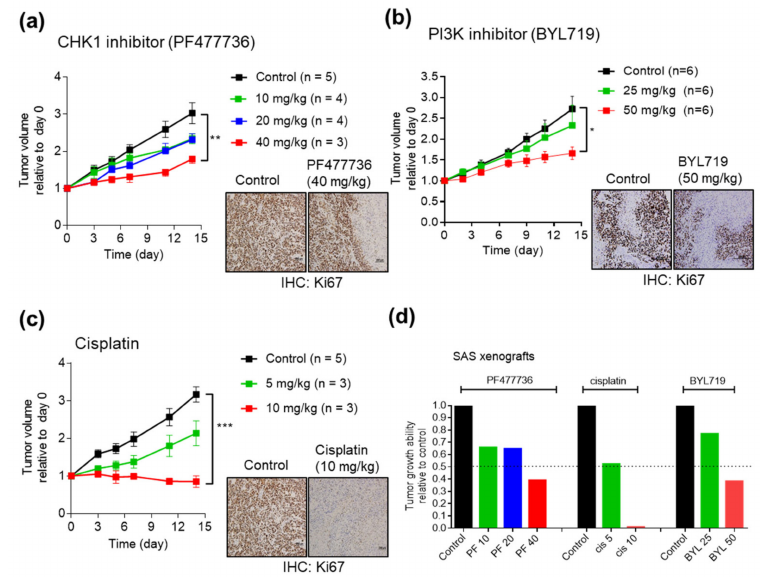
Figure5. E ff ectsoftheCHK1inhibitorPF477736andthePI3KinhibitorBYL719inOSCCcellline-derived xenografts. SAS cells were injected into the subcutaneous tissues of NOD / SCID mice, and when the tumors attained a volume of 300–500 mm 3 , the mice were divided into di ff erent experimental groups. Xenografted mice were administered a vehicle control, PF477736 (10, 20, or 40 mg / kg) ( a ); BYL719 (25 or 50 mg / kg) ( b ); or cisplatin (5 or 10 mg / kg) ( c ). The treatment protocols and timelines are described in the Materials and Methods. ( d ) Summary of treatment responses showing the tumor volumes relative to the control. Tumors were measured and tumor volumes were calculated at the indicated times. Ki67 staining was significantly reduced in the treatment group, suggesting a reduction in cancer cell proliferation. The data are expressed as the mean ± SEM values. Statistical analysis of the di ff erences between the two groups was performed with a Student’s t -test. * p < 0.05; ** p < 0.01; *** p <